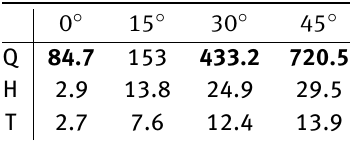
The significant reduction of the initial global structural stiffness with respect to the original configuration θ = 0 ∘ is not reflected in a corresponding significant variation of the load factors. If the free edge orientation doesn’t have a rele-